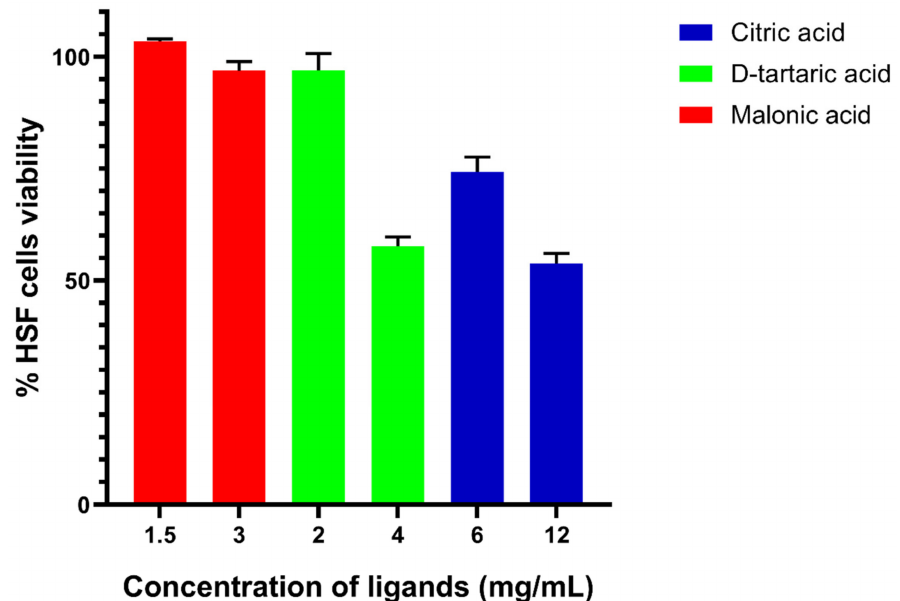
Figure 8. A bar chart representing the cytotoxicity of candidate ligands, citric acid, D-tartaric acid and malonic acid, against Human Skin Fibroblast (HSF) using a Sulforhodamine B (SRB) assay. Each candidate ligand was tested at two different concentrations equivalent to 5 × and 10 × its MIC against A. baumannii ATCC 19606. Results are presented as percent viable HSF cells. The values represent an average of three samples tested for each candidate ligand. Error bars represent SD values.